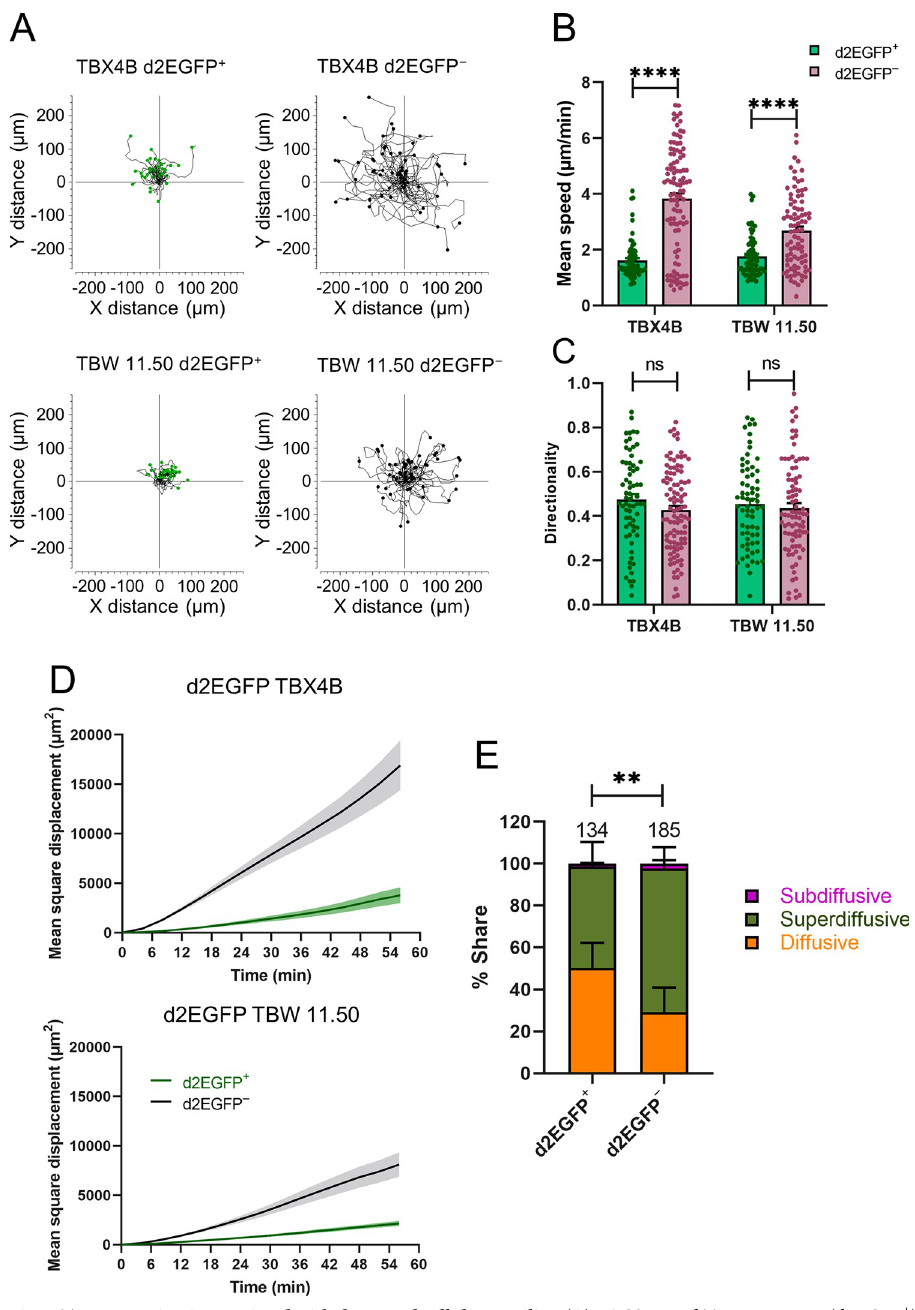
Fig 5. Tax expression is associated with decreased cellular motility. (A) FACS-sorted Tax-expressing (d2EGFP + ) and non-Tax-expressing (d2EGFP − ) cells were mixed 1:1 and seeded into wells containing a polymer insert with an array of 500 μ m x 500 μ m wells. Time-lapse live-cell imaging was performed for 1 hour, capturing images at either 3- or 4-minute intervals in phase (d2EGFP − cells), green (d2EGFP + cells) and red (YOYO-3 Iodide–dead cells) channels. Single-cell tracking and analysis, described in Materials and methods, was used to determine cell motility. Trajectory plots of d2EGFP + and d2EGFP − cells from clones d2EGFP TBX4B and d2EGFP TBW 11.50 after transforming the starting coordinates of all cells to a common (0, 0) origin. The trajectories from a single representative experiment of two independent experiments are shown. The number of trajectories shown are: TBX4B d2EGFP + – 42, TBX4B d2EGFP − – 55, TBW 11.50 d2EGFP + – 33, TBW 11.50 d2EGFP − – 56. (B) Mean speed and (C) directionality of d2EGFP + and d2EGFP − cells. Number of cells analysed: TBX4B d2EGFP + – 68, TBX4B d2EGFP − – 101, TBW 11.50 d2EGFP + – 67, TBW 11.50 d2EGFP − – 87. The mean and SEM from two independent experiments are shown. (D) Mean square displacement of d2EGFP + and d2EGFP − cells from two clones. The mean ± SEM from a